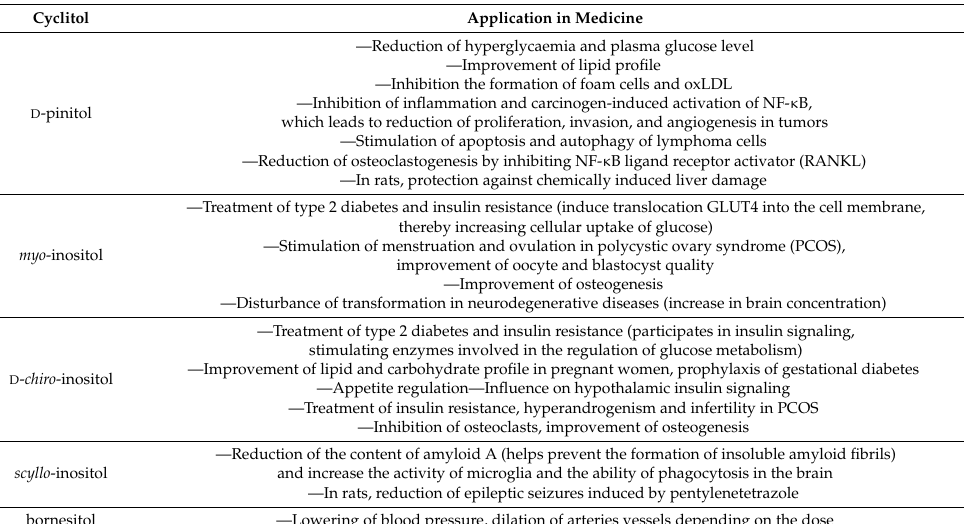
Table 3. Cyclitols—Indications in